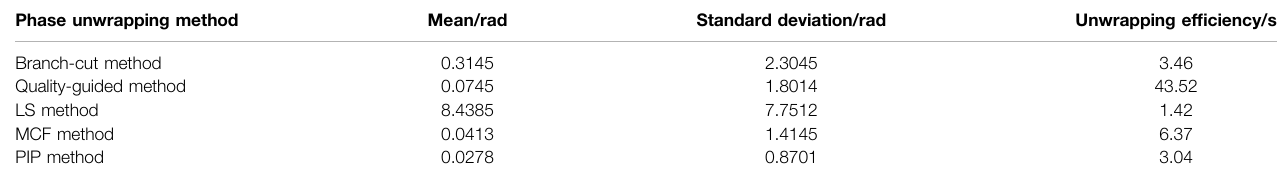
TABLE 2 | Evaluation of different phase unwrapping methods.